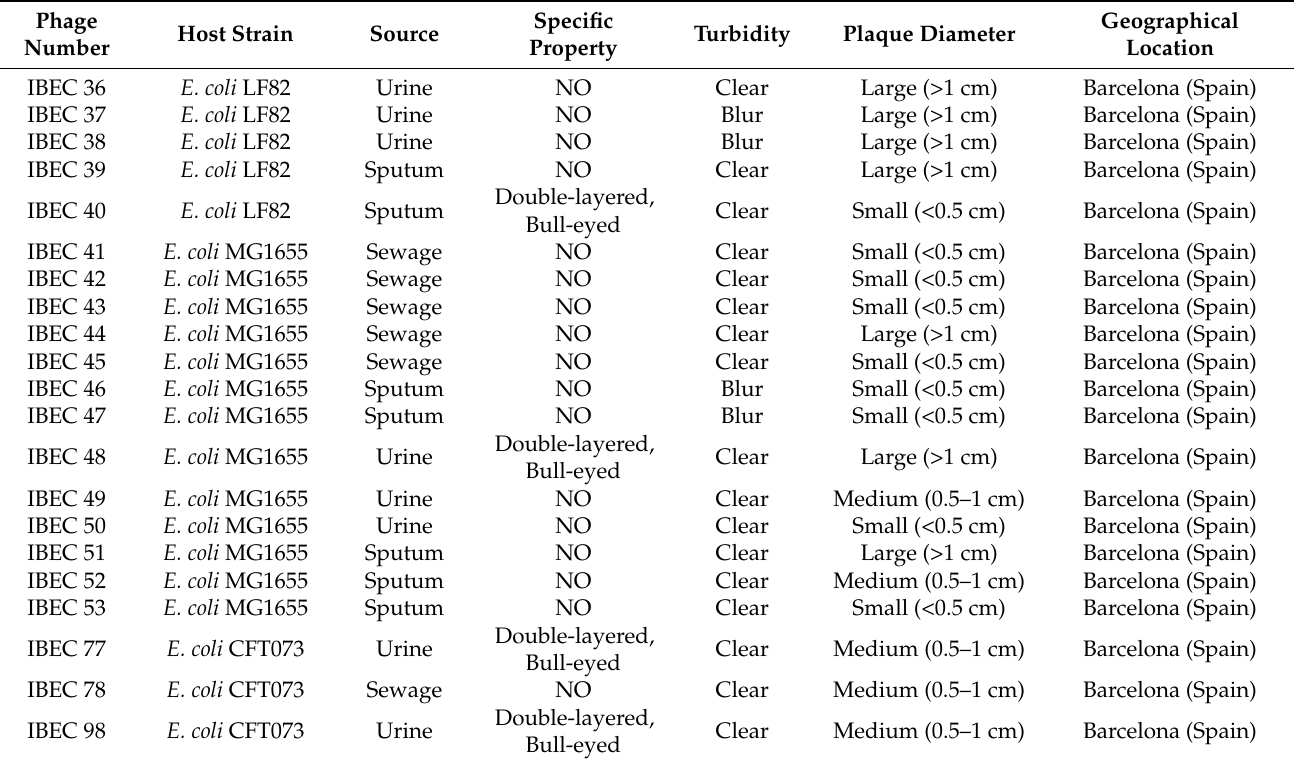
Table 1. Different phages were isolated from clinical and environmental